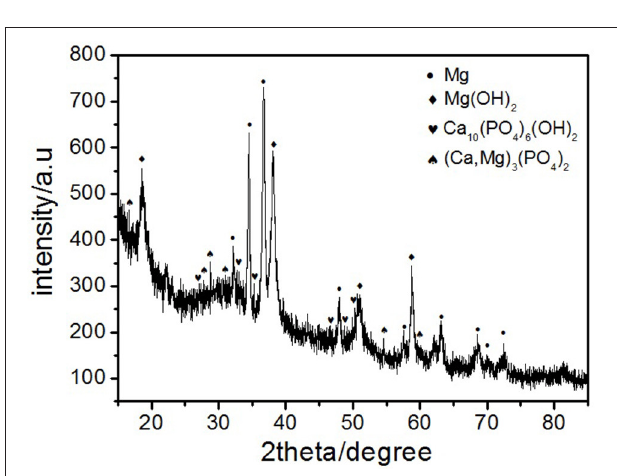
FIGURE 12 | X-ray diffraction patterns of the corrosion products of as-cast alloy after immersion in SBF for 120h.